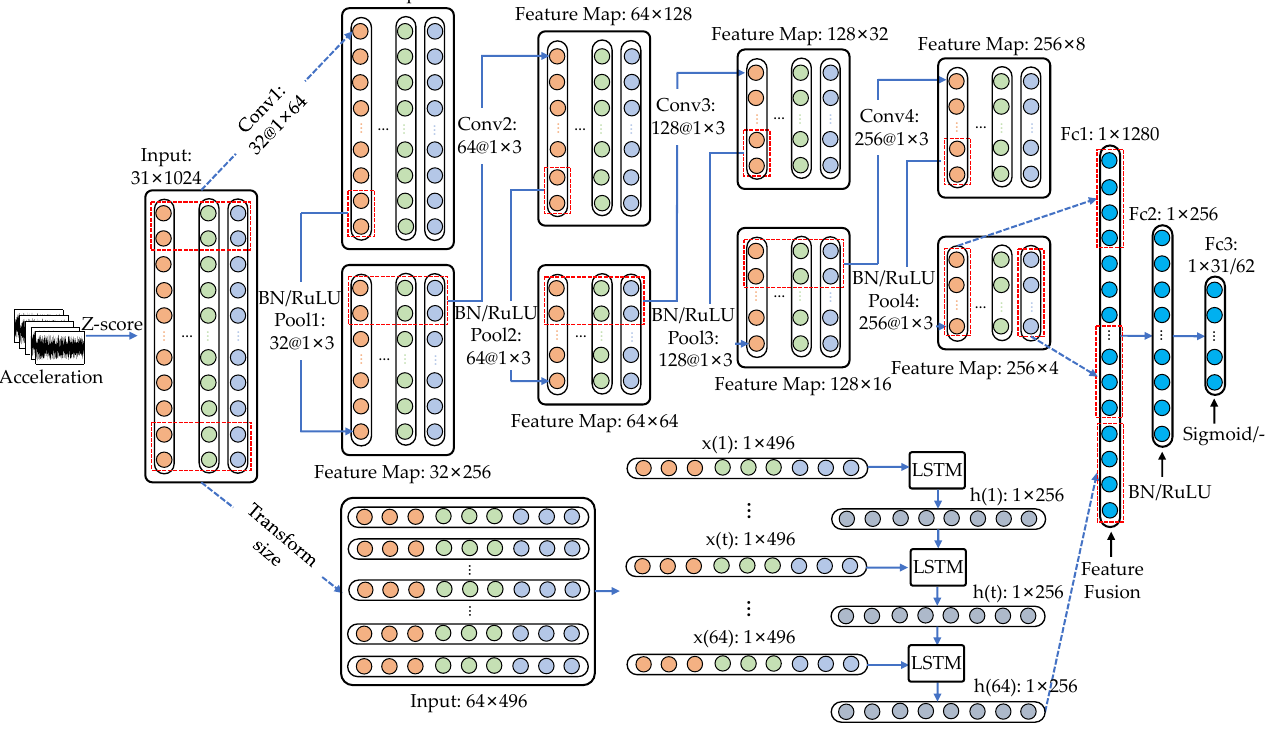
Figure 7. Architecture of the proposed CNN-LSTM. Table 2. Parameters of CNN-LSTM.